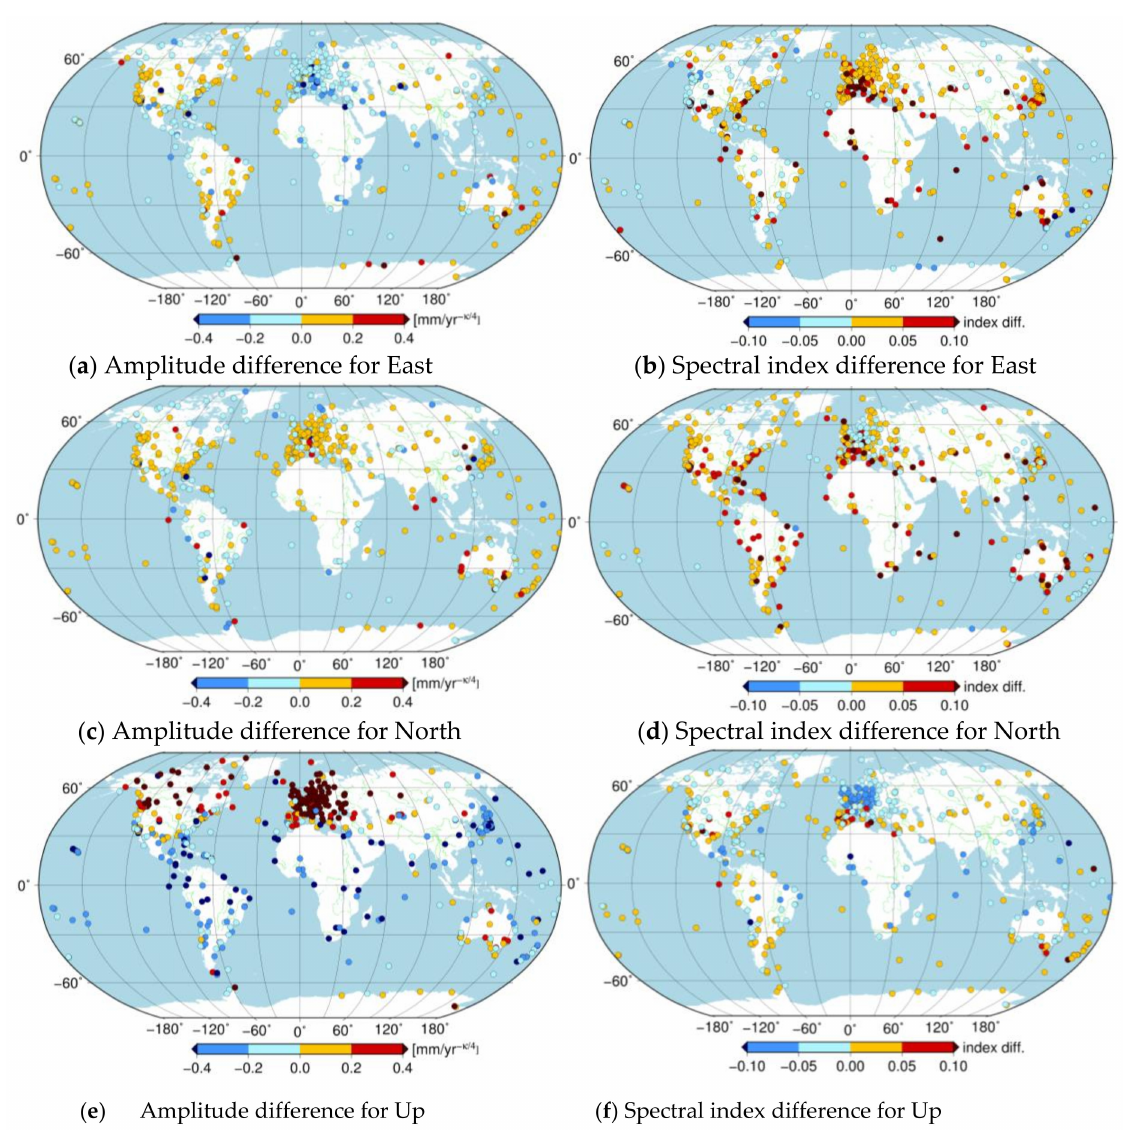
Figure 8. Amplitudes and spectral indexes differences between the solution igs_unit_none and igs_cova_trs for the global distributed